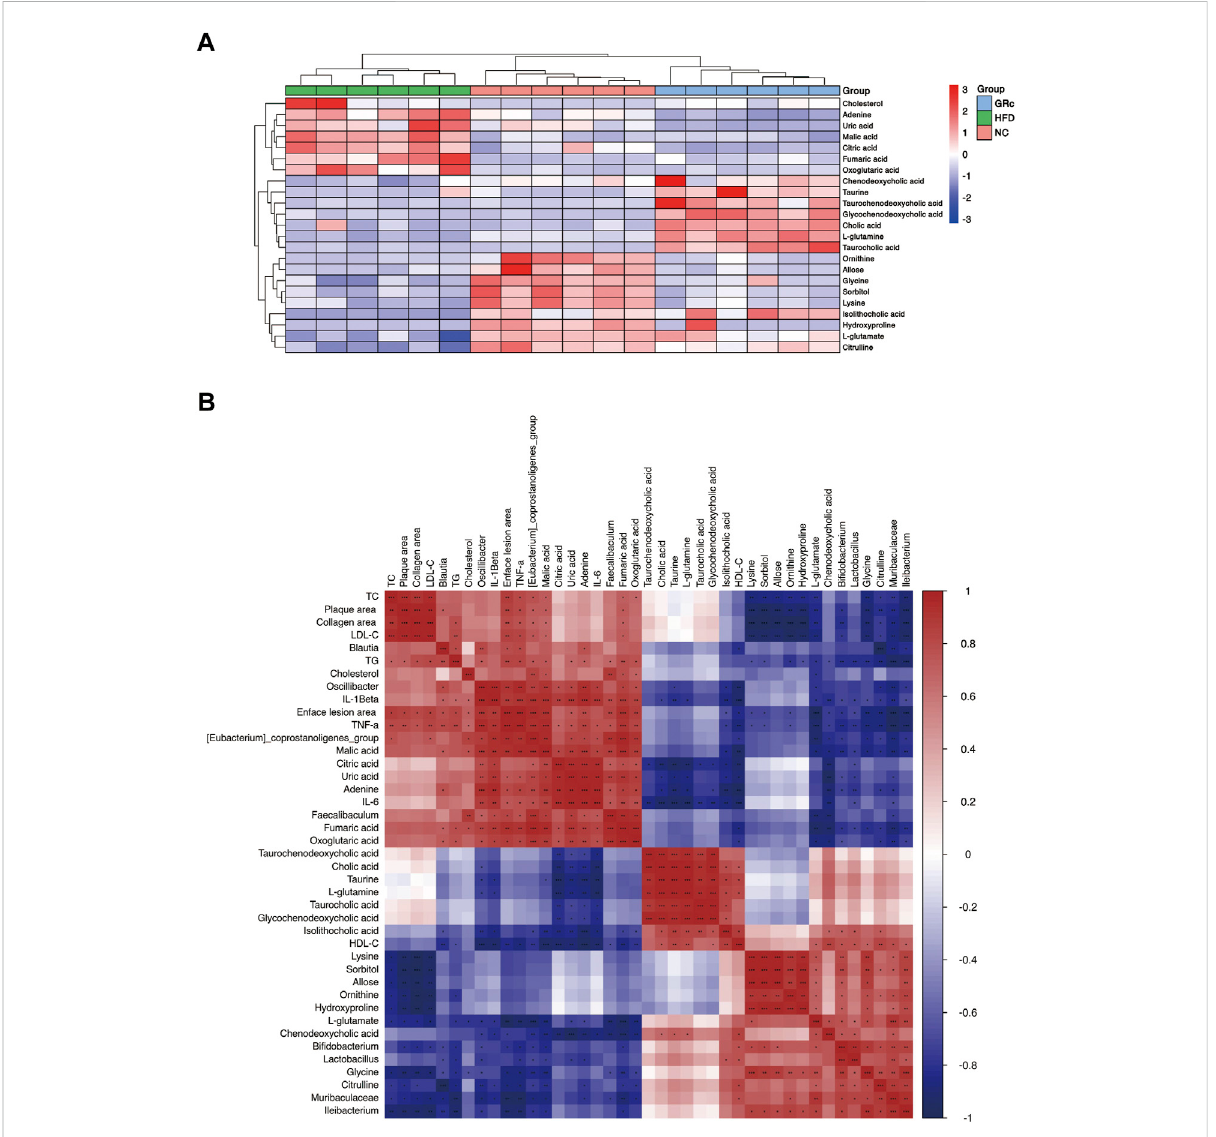
FIGURE 9 Correlation between gut metabolism and atherosclerosis. (A) Clustering heatmap of potential biomarkers in feces. (B) Spearman correlation analysis among gut microbiota, differentially expressed fecal metabolites, and atherosclerotic parameters. The correlation analysis value is represented by the colors of grinds. Red represents positive correlation, and blue represents negative correlation. * p < 0.05, ** p < 0.01, and *** p < 0.001 (NC, normal control; HFD, high-fat diet; GRc, ginsenoside